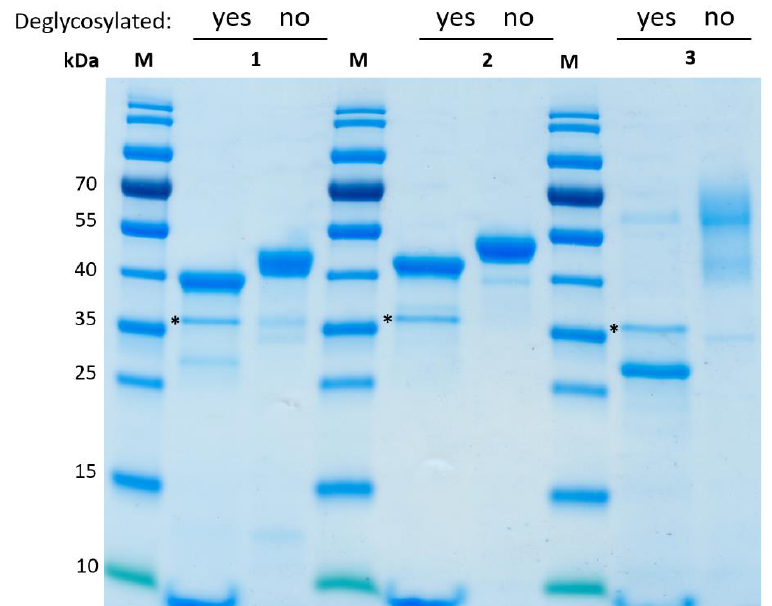
Figure 5. Analysis of protein purity and glycosylation content of purified proteins before and after N-deglycosylation with PNGase F. Lanes: M PageRuler Prestained (ThermoFisher), 1 r Cab UPO 1, 2 r Cab UPO 2, 3 r Ani UPO. The band representing PNGase F (35.9 kDa) is indicated (*). Table 3. Size and spectroscopic characteristics of r Cab UPO 1, r Cab UPO 2, and r Ani UPO. Molecular mass of glycosylated and deglycosylated UPO proteins were calculated from Figure 5. Molecular weights of the mature proteins, i.e., excluding the N-terminal secretion signal, were predicted using SignalP 5.0 [28].